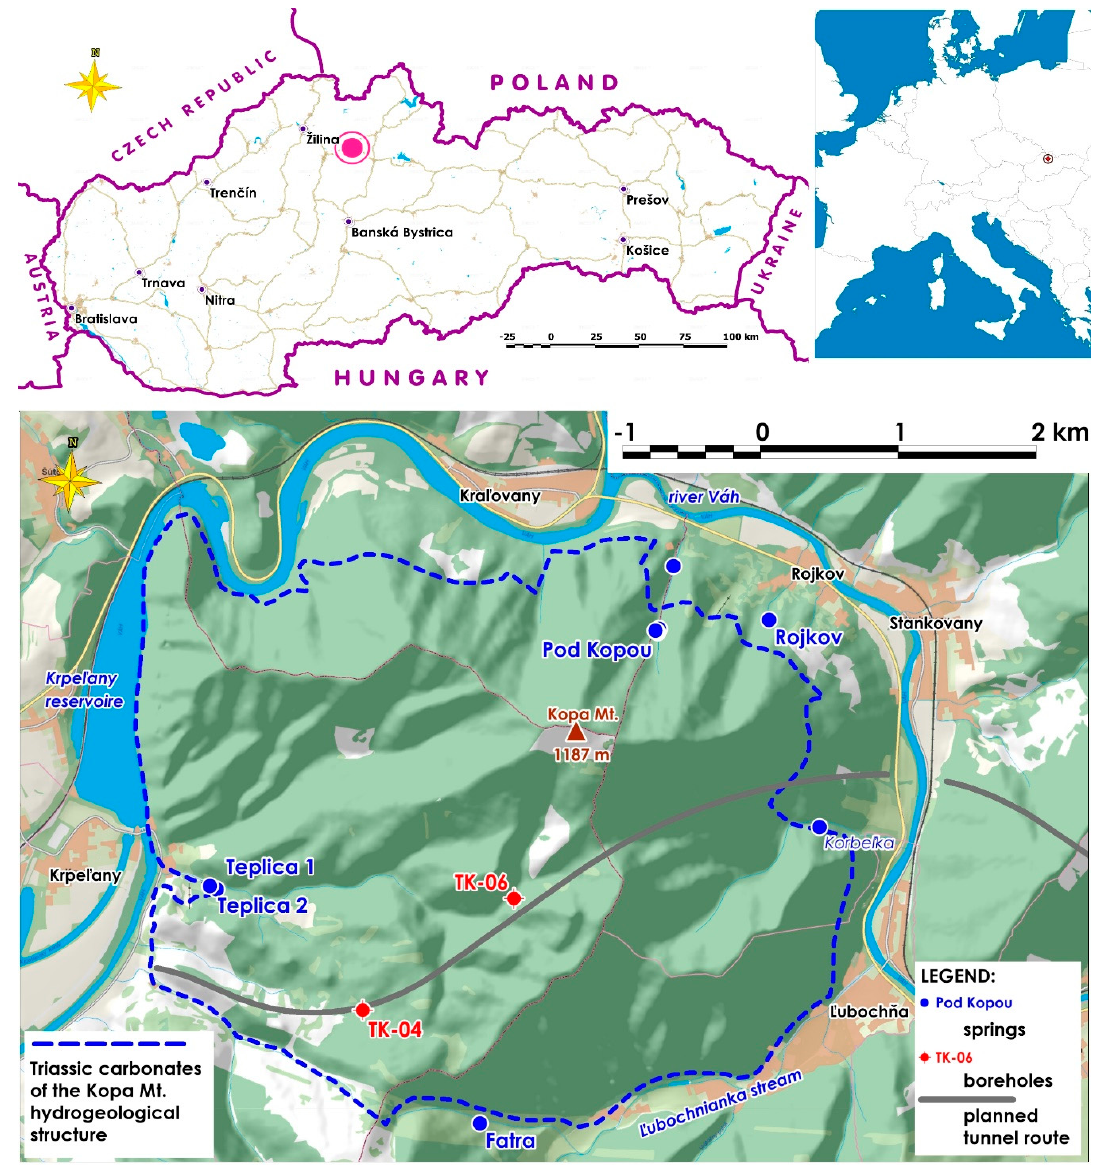
Figure 1. Karstic aquifer of the Kopa Mt. (49.137192°N, 19.138167°E) hydrogeological structure, NW part of the Ve ľ ká Fatra Mts., West Carpathians, Central Slovakia—topographical map, planned tunnel route, and monitored objects.